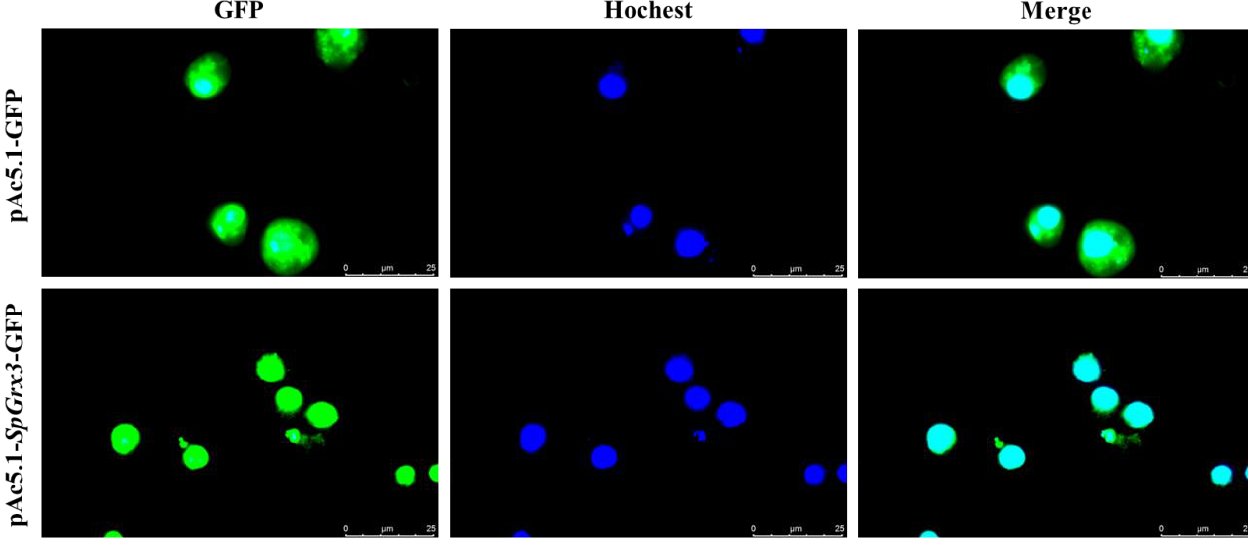
Figure 7. The subcellular localization of SpGrx3 protein in S2 cells. S2 cells were transfected with pAc5.1-GFP (upper row) or pAc5.1- SpGrx3 -GFP (lower row). The cell nucleus was stained with Hoechst33342 (blue) and fluorescence was observed using confocal laser scanning microscopy.